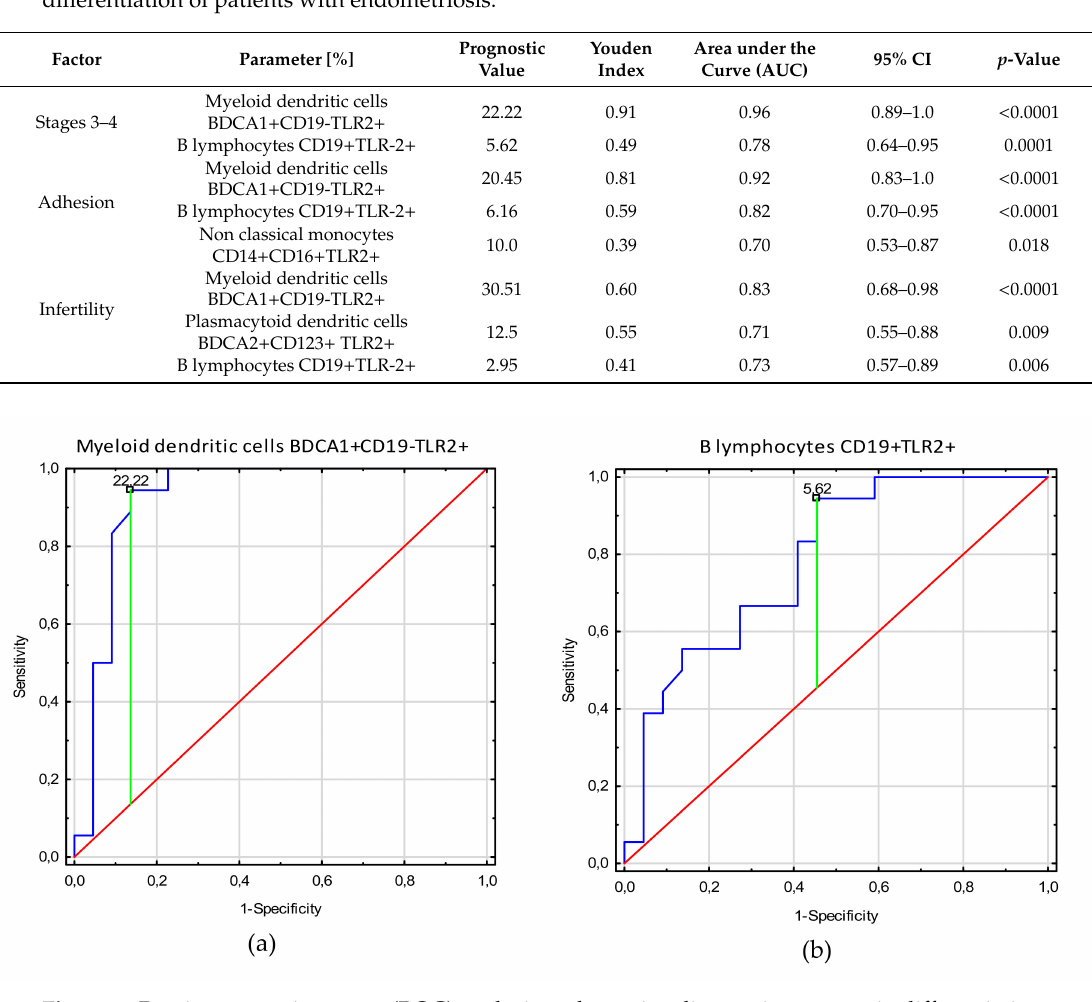
Figure 2. Receiver operating curve (ROC) analysis to determine diagnostic accuracy in di ff erentiation of patients with endometriosis stages 3–4 and with endometriosis stages 1–2: ( a ) frequencies of myeloid dendritic cells BDCA1 + CD19-TLR2 + [%]; ( b ) frequencies of B lymphocytes CD19 + TLR2 +